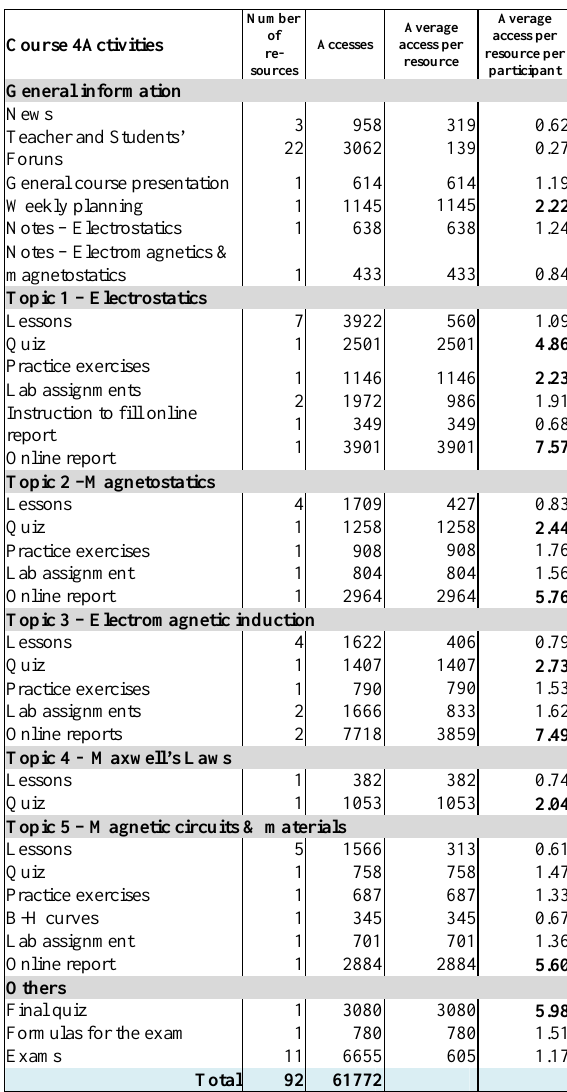
TABLE VI. M OODLE C OURSE 4 ACESSES PER RESOURCE AND